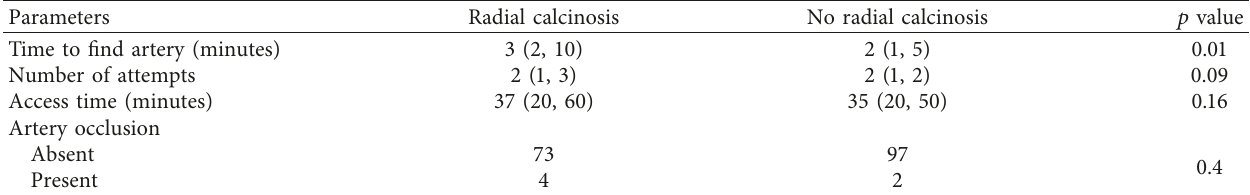
Table 5: Median values of the parameters involved in the performance of the radial punction (interquartile ranges). Parameters Radial